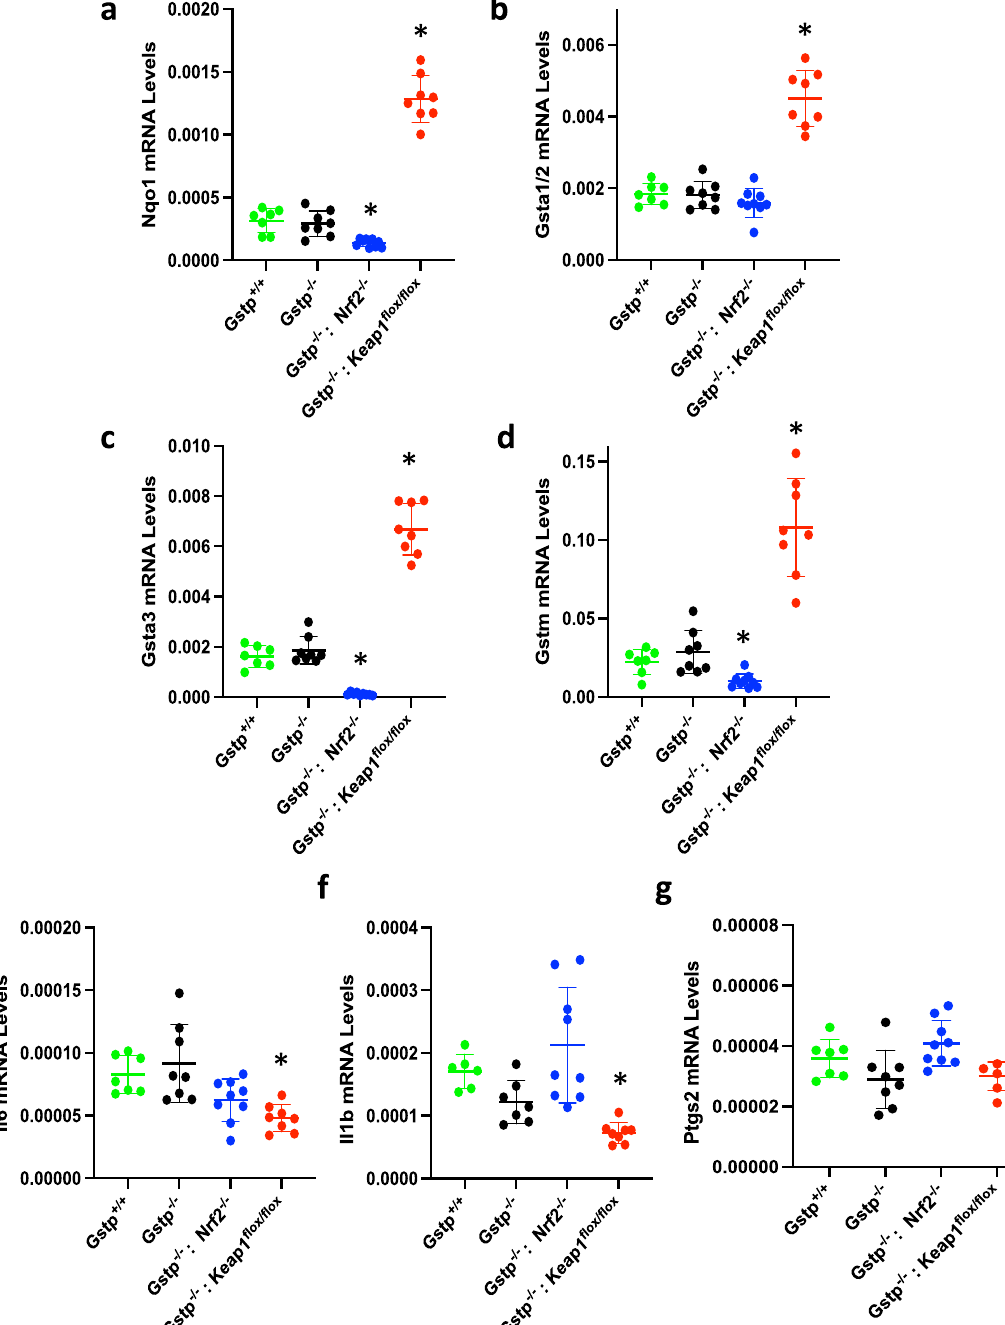
Fig. 1 The expression of classical Nrf2 targets and pro-in fl ammatory genes is not affected by deletion of Gstp . mRNA levels for Nqo1 ( a ), Gsta1/2 ( b ), Gsta3 ( c ), Gstm ( d ), Il6 ( e ) Il1 β ( f ), and Ptgs2 ( g ) in colon tissue of Gstp + / + : Nrf2 + / + : Keap1 + / + (green circles), Gstp − / − : Nrf2 + / + : Keap1 + / + (black circles), Gstp − / − : Nrf2 − / − : Keap1 + / + (blue circles), and Gstp − / − : Nrf2 + / + : Keap1 fl ox/ fl ox (red circles) female mice ( n = 8). Results are expressed as relative values to the Gstp + / + : Nrf2 + / + : Keap1 + / + genotype. Actb was used as the reference gene. * p < 0.01 (compared to Gstp + / + : Nrf2 + / + : Keap1 + / +